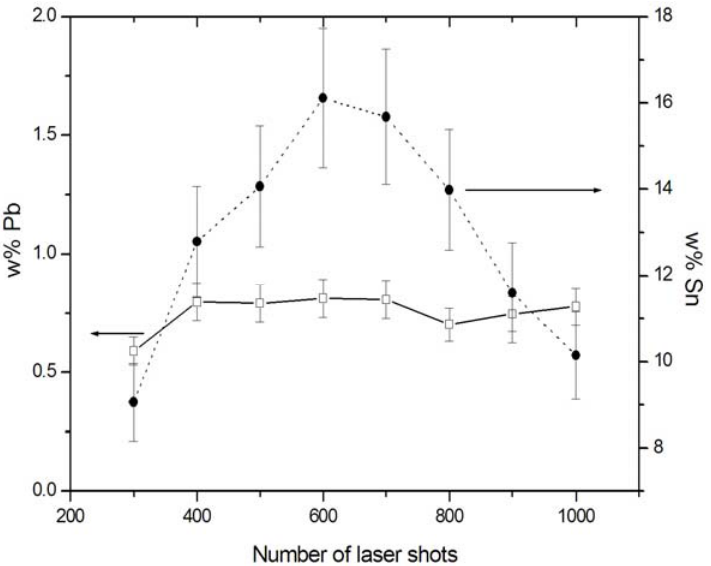
Figure 2. Sn and Pb weight percentages (w%) in a fragment of a bronze basin as a function of the number of laser shots focused on the sample. Each spectrum resulted from 100 accumulations, with laser energy 1.5 mJ and focused laser spot of diameter 200  m. The sample was drilled through from side to side, displaying a significant depletion of Sn in the external